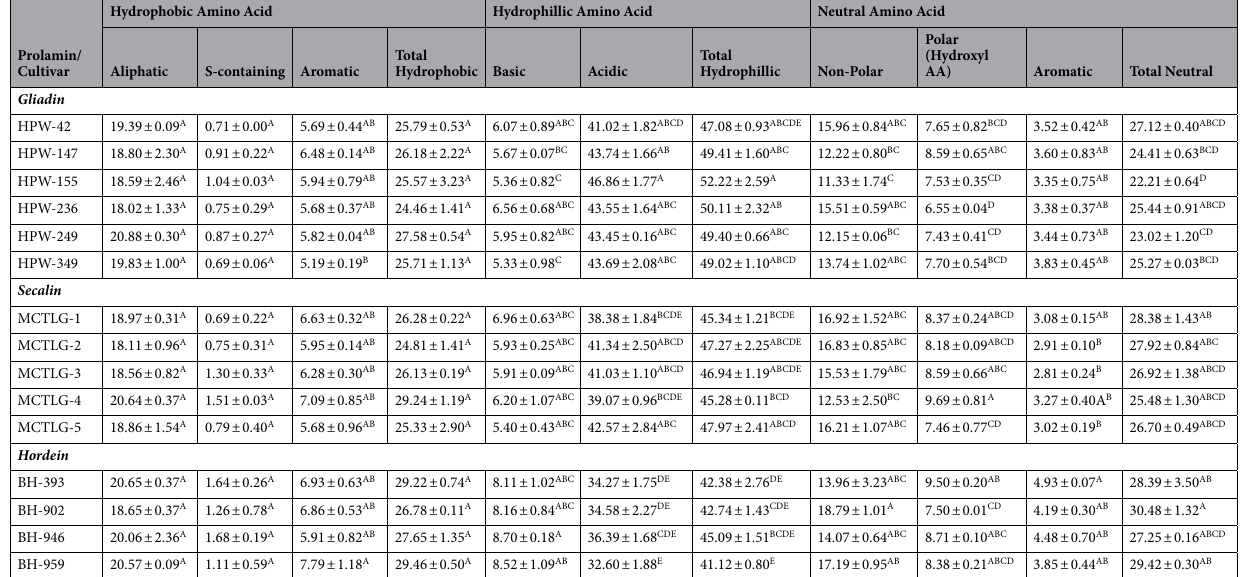
Table 4. IMGT (ImMunoGeneTics) Amino Acid Classification (Pommie et al.,2004) of gliadin, secalin and hordein fractions (g amino acid/100 g protein) from different cultivars. Aliphatic amino acid: Alanine + Valine + Isoleucine + Leucine, S-containing amino acids: Cysteine + Methionine, Basic amino acids: Arginine + Lysine + Histidine, Acidic amino acids: Aspartic + Glutamic acid, Hydrophobic Aromatic